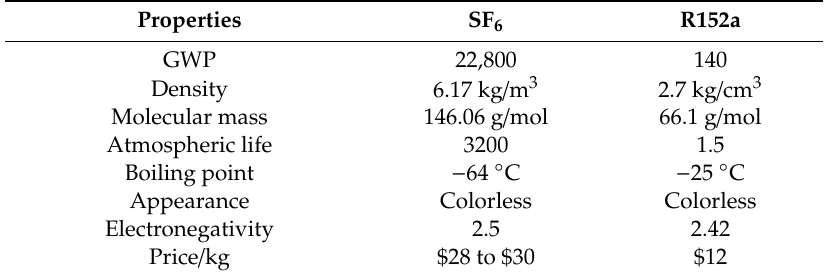
Table 4. Contrast between physical and chemical properties of SF 6 versus R152a [20]. The global warming potential represents the values over a time span of 100 years for equal masses of these gases